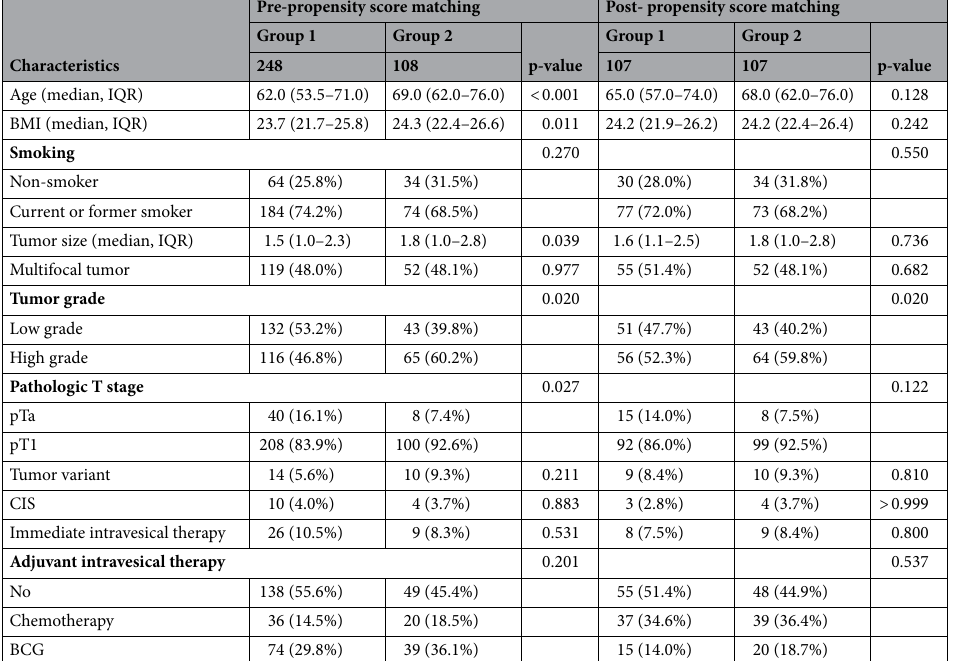
Patients characteristics. Table 1 shows the patients’ clinical and pathologic characteristics of all cohort and propensity score matched cohort. The median age (69.0 vs 62.0 years, p < 0.001) and body mass index (BMI) (24.3 vs 23.7, p = 0.011) were higher in group 2 than in group 1. Tumor size was also greater in group 2 (1.8 cm vs 1.5 cm, p = 0.0.39). Additionally, high-grade tumors (60.2% vs 46.8%) and T1 stage tumors (92.6% vs 83.9%) were more frequently observed in group 2 than in group 1. There was no difference in the other variables. After propensity score matching (PSM), there was no difference in all variables between two groups. Recurrence‑free and prognosis‑free survival in the 2 groups (before PSM). In the median fol- low up duration of 52 months (interquartile range: 38–72 months), 66 patients (26.6%) experienced recurrence in group 1 and 53 patients (49.1%) in group 2, while 8 patients (3.2%) experienced progression in group 1 and 14 patients (13.0%) in group 2. Figure 1 showed Kaplan–Meier curves of recurrence-free survival (RFS) and progression-free survival (PFS) in two groups. The 5-year RFS was higher in group 1 than in group 2 (69.3% vs 47.0%, p = 0.001), and so was the PFS (96.7% vs 87.7%, p = 0.002). Multivariable cox-regression analysis showed that tumor size (hazard ratio [HR] = 1.286, 95% confidential interval [CI] = 1.119–1.477, p < 0.001) and multifocal tumor occurrence (HR = 1.838, 95% CI = 1.251–2.700, p = 0.002) were associated with RFS. Adjuvant intravesical BCG instillation was associated with better RFS (HR = 0.605, 95% CI = 0.394–0.929, p = 0.022), although intravesical chemotherapy did not lower RFS (HR = 0.634,